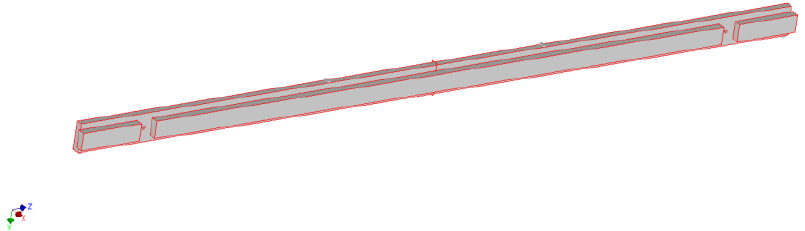
Figure 1. Selected geometric model of the continuous long frame version A made of solid wood material.